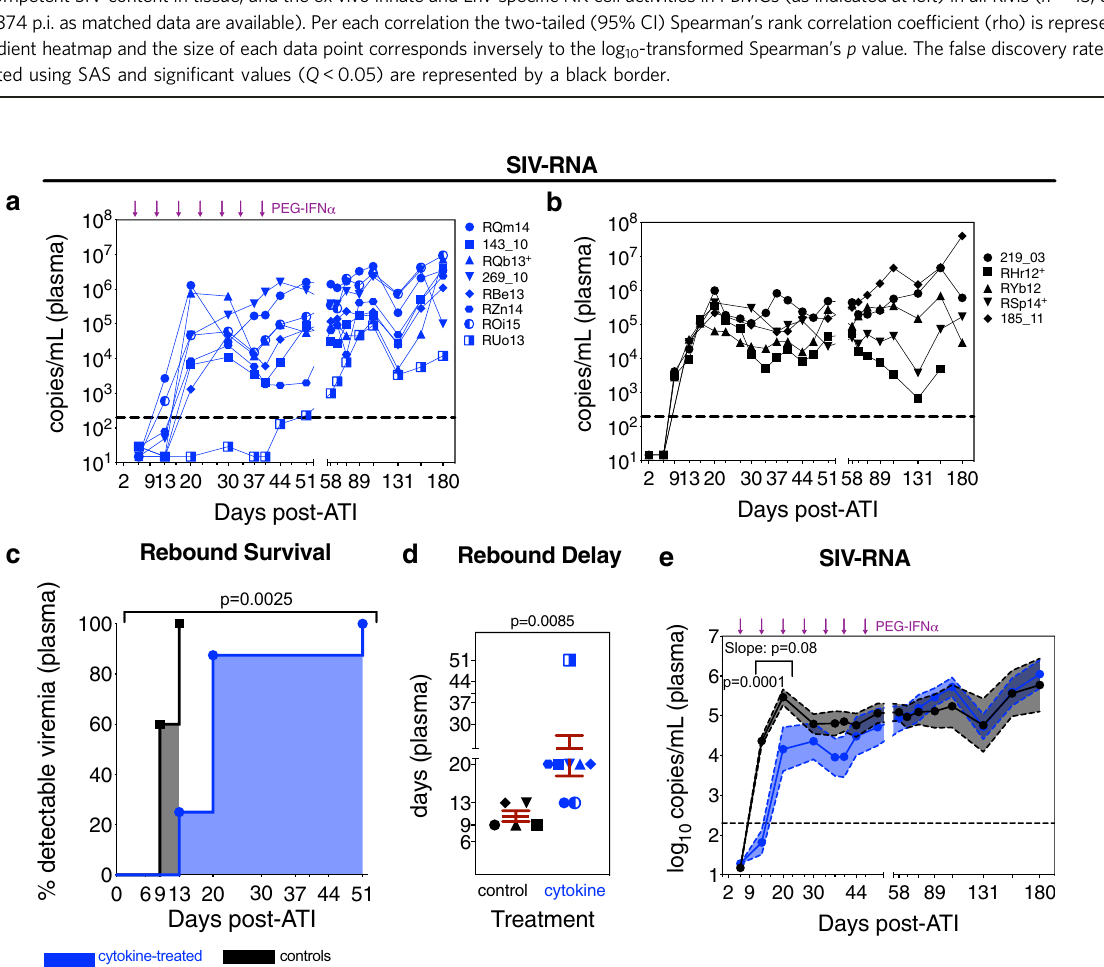
Fig. 4 Cytokine therapy delays the rebound of plasma viremia following ATI. Following ART analytical treatment interruption (ATI), the plasma SIV-RNA copies/mL were measured by qRT-PCR in each a cytokine-treated (PEG-IFN α with prior ART + IL-21 + rIFN α , blue; n = 8 RMs) and b control RMs (prior ART-only, black; n = 5 RMs). The horizontal dashed line (200 copies/mL) represents the threshold for virologic rebound and PEG-IFN α treatments are indicated by the purple arrows above. These kinetics of plasma viremia following ATI were then re-visualized as follows: c The delay in rebound of plasma viremia was represented as a treatment-strati fi ed survival curve, which was analyzed with a Log-rank Mantel – Cox test. d The delay in viral rebound, in days, per each RM was represented as a color and shape-coded symbol overlaid against the mean ± SEM (red), which was analyzed with a two-sided (95% CI) Mann – Whitney U test. e The log 10 SIV-RNA copies/mL are given as a longitudinal mean (solid line with closed circles) ± SEM (color-coded shaded region within the dashed lines), which was analyzed with a two-sided (95% CI), two-way ANOVA with Bonferroni ’ s correction for multiple comparisons across treatments (d13 p = 0.0001), and a mixed-effects linear model was used to analyze the slope between d13 and d20 post ATI (as indicated by the bracket; p = Tissue collection and processing . Collections of peripheral blood (PB), RB distance into the rectum and 20 punches were collected using a biopsy forcep. To punches, and LN biopsies were conducted longitudinally and upon necropsy obtain gut-derived lymphocytes, RB punches were digested with 1mg/mL col- (Fig. 1a) as previously described 44 . EDTA PB was used for complete blood counts, lagenase for 2h at 37°C with agitation, and then fi ltered with a 100- μ m strainer to and plasma was separated by centrifugation within 1 h of phlebotomy. PBMCs remove residual tissue fragments. For LN biopsies, the skin over the axillary or were isolated from PB by density gradient centrifugation (Ficoll-Paque Premium, inguinal region was clipped and surgically prepped. An incision was then made in GE Healthcare). RB punches were obtained by inserting an anoscope a short the skin and the LN was exposed by blunt dissection and excised over clamps. LNs